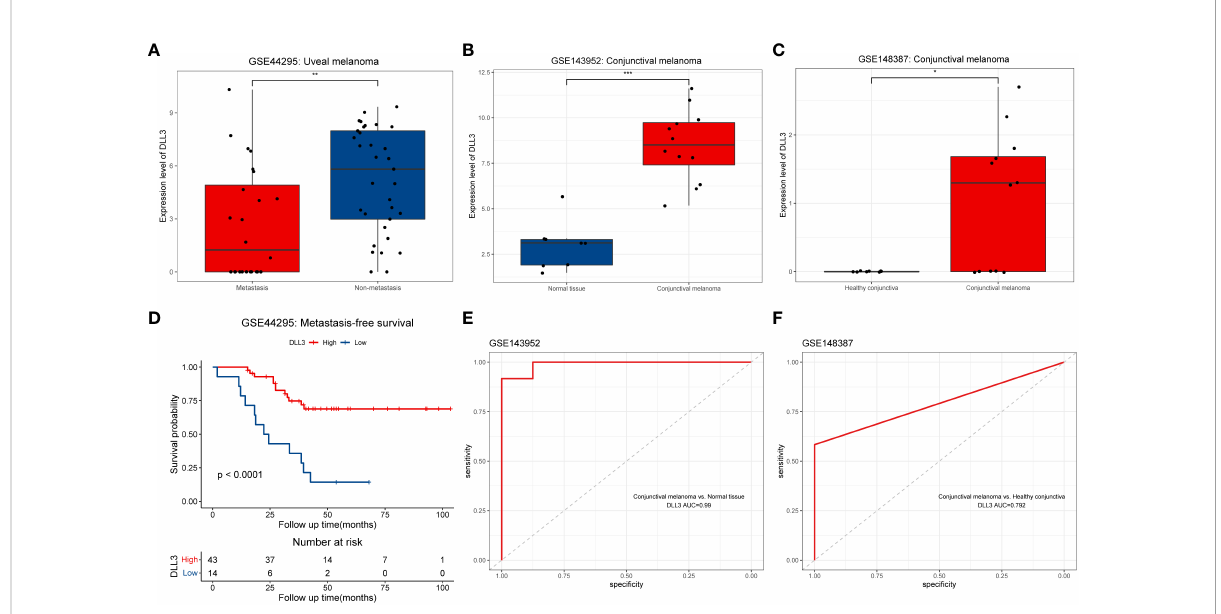
FIGURE 5 External validation of the prognostic value of DLL3 expression in UM and investigation of the diagnostic performance in CM. (A-C) Boxplots to show the expression levels of DLL3 in ocular melanoma and normal tissues from three datasets including GSE44295 (A) , GSE143952 (B) , and GSE148387 (C) . (D) Kaplan-Meier curve indicated that UM patients with higher DLL3 expression have longer metastasis-free survival. (E, F) The ROC curves indicated that DLL3 expression showed a promising power to distinguish CM samples from normal tissues with an AUC value of 0.99 in GSE143952 (E) and 0.792 in GSE148387 (F) . * P < 0.05, ** P < 0.01, *** P <